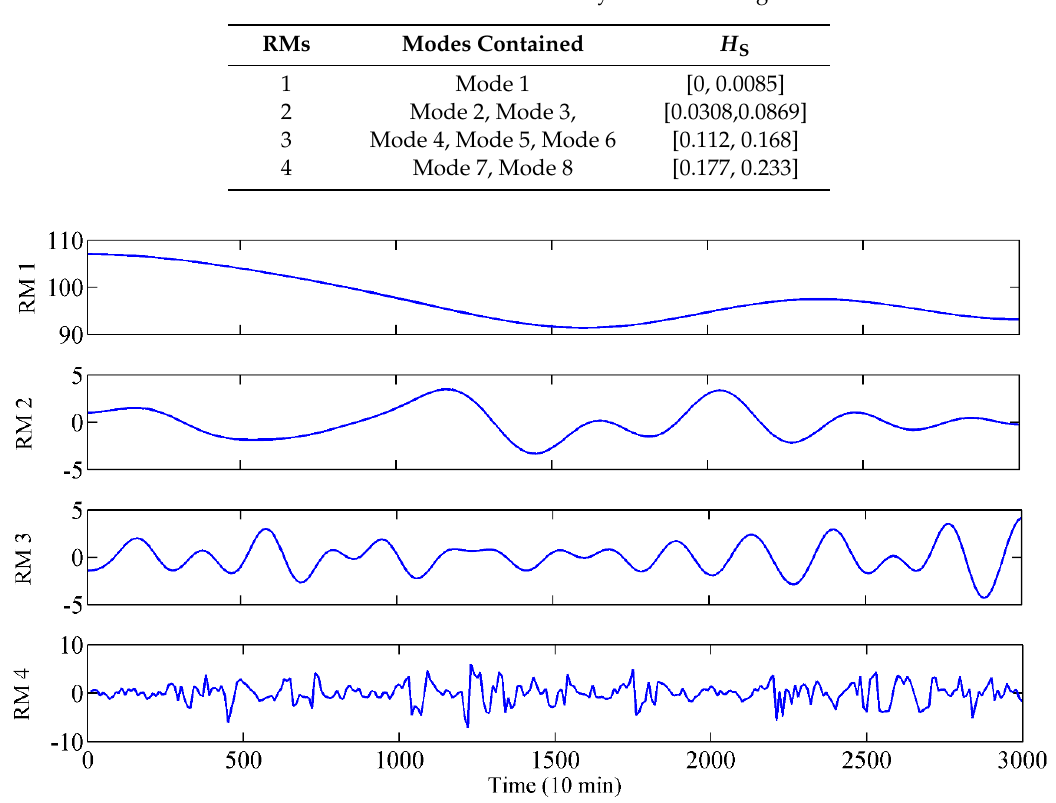
Figure 6. RM obtained from EWT and SE ‐ based reconstruction.